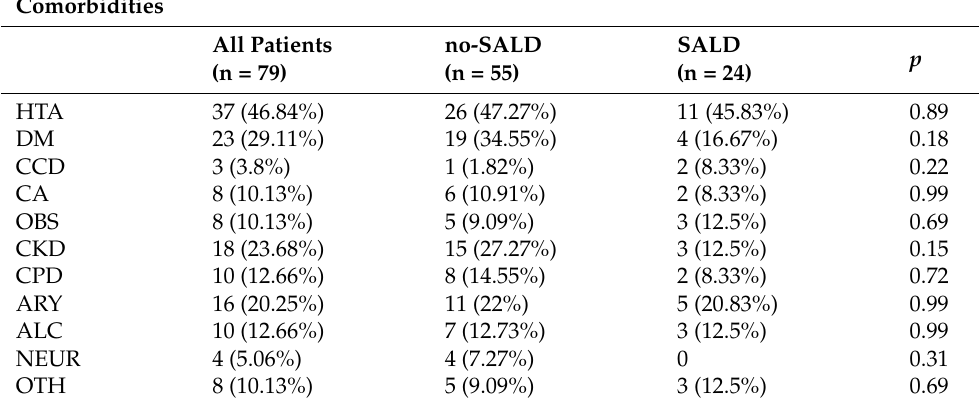
Table 2. Comorbidities of the patients.